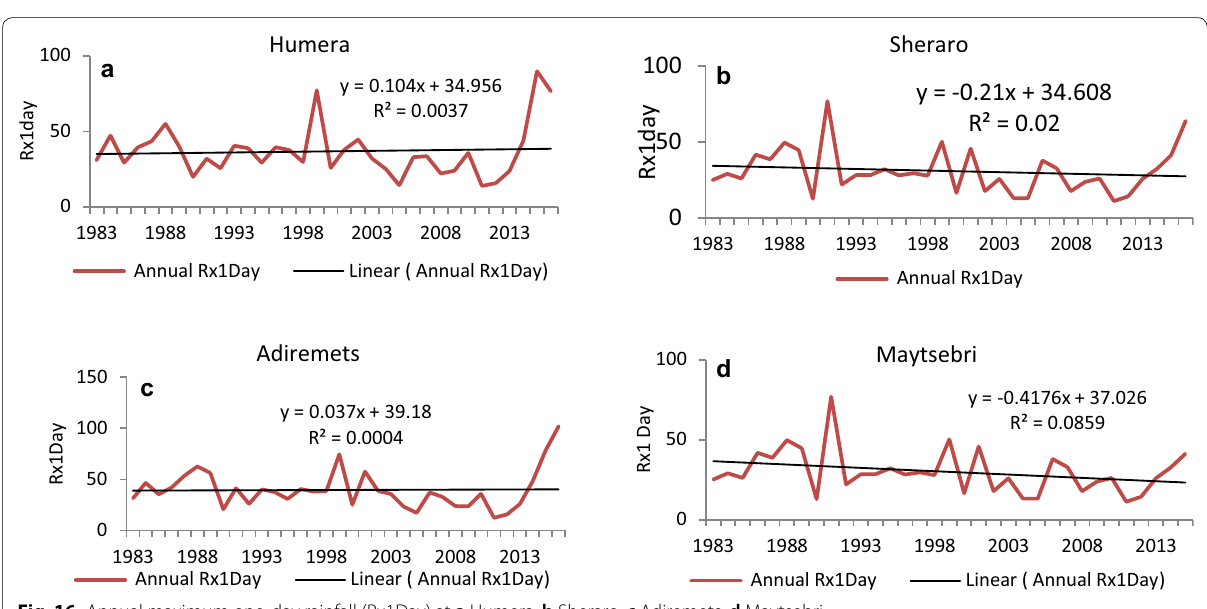
rainfall The maximum average annual Rx1day rainfall (Fig. 16) revealed a negative trend in most of the stations, except at Humera, Dansha, and Adiremets. The maximum Rx1day